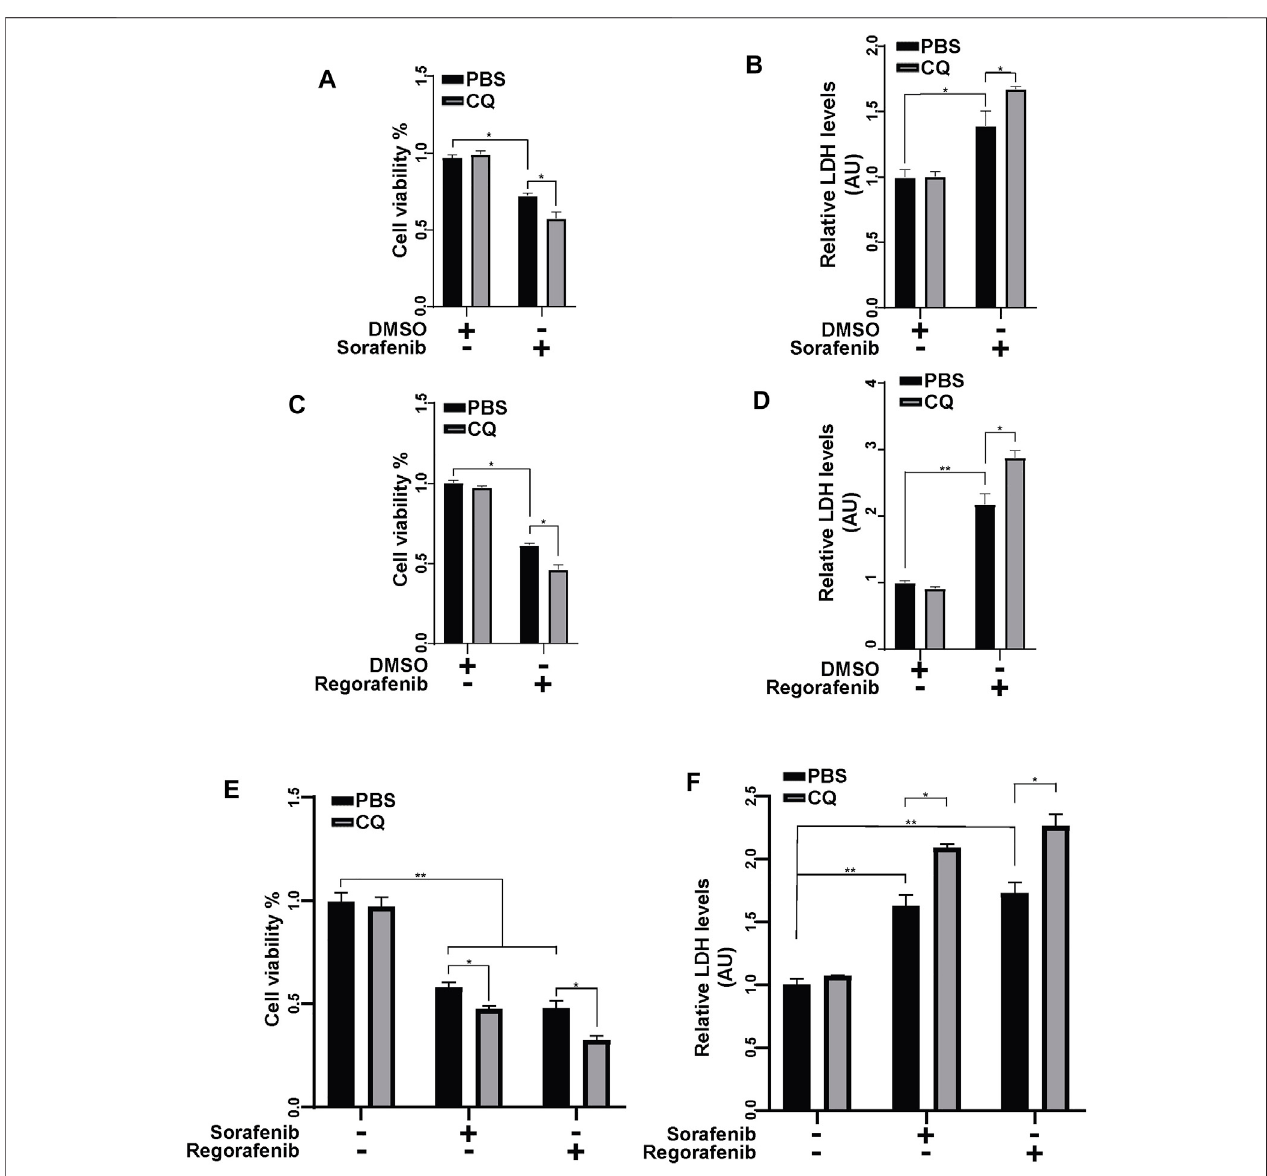
FIGURE 6 | Inhibiting mitophagy enhances the anticancer effect of sorafenib and regorafenib in HCC cells. (A) Cell viability was measured using a CCK-8 kit in HepG2 cells that were pretreated with CQ (50 μ M) for 2 h and then treated with sorafenib (20 μ M) for 24 h. Values are the mean ± SEM from four independent experiments (* p < 0.05, two-way ANOVA and Tukey ’ s multiple comparisons test). (B) Cytotoxicity wasmeasured using LDH assays in HepG2 cells that were treated as in A. Values are the mean ± SEM from three independent experiments (* p < 0.05, ** p < 0.01, two-way ANOVA and Tukey ’ s multiple comparisons test). (C,D) Cell viability and cytotoxicity were measured in HepG2 cells that were treated as described in (A,B) but with regorafenib (30 μ M). Values are the mean ± SEM from four independent experiments (* p < 0.05, ** p < 0.01, two-way ANOVA and Tukey ’ s multiple comparisons test). (E) Cell viability was measured using a CCK-8 kit in Hep3B cells that were pretreated with CQ (50 μ M) for 2 h and then treated with sorafenib (20 μ M) or regorafenib (30 μ M) for 24 h. Values are the mean ± SEM from four independent experiments (* p < 0.05, two-way ANOVA and Tukey ’ s multiple comparisons test). (F) Cytotoxicity was measured using LDH assays in Hep3B cells that weretreatedasin (E) .Values arethemean± SEMfromthree independent experiments(* p < 0.05,** p < 0.01, two-way ANOVA and Tukey ’ smultiple comparisonstest).